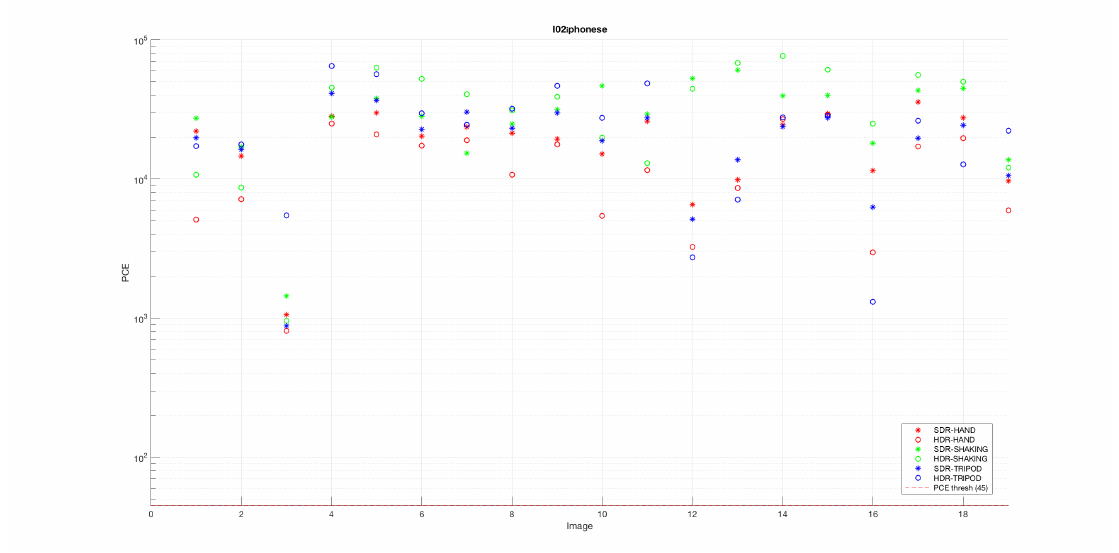
Figure 7. Example of the result obtained when correlating noise from HDR images captured by the I02 model with the SDR image fingerprint. I, iOS.